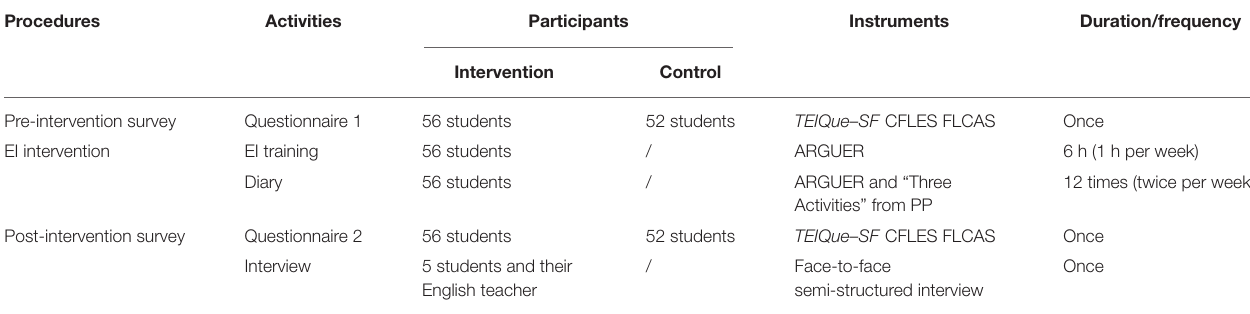
TABLE 5 | Summary of the intervention